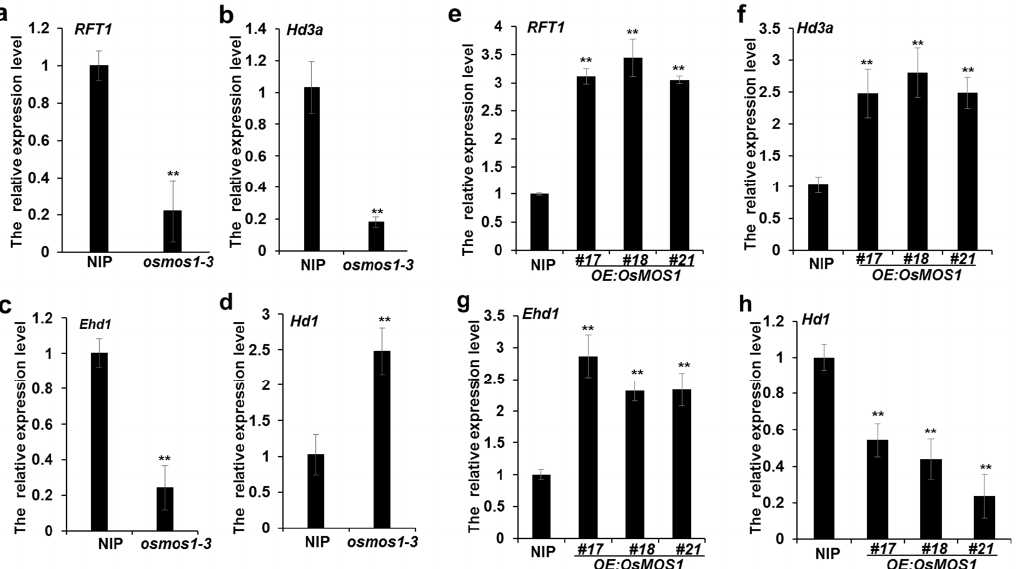
Figure 5. Expressions of the floral regulator genes in Nip, osmos1-3 , and OsMOS1 -overexpressing lines under LD conditions. ( a – d ) Expressions of the RFT1 ( a ), Hd3a ( b ), Ehd1 ( c ), and Hd1 ( d ) in Nip and osmos1-3 under LD conditions. ( e – h ) Expressions of RFT1 ( e ), Hd3a ( f ), Ehd1 ( g ), and Hd1 ( h ) in NIP and OsMOS1 -overexpressing lines under LD conditions. The fully emerged leaf blades from Nip, osmos1-3 , and OsMOS1- overexpressing plants under LD growth conditions were sampled at 45 days after germination. The expression of Hd1 was observed at ZT 14 h and other floral regulator genes were monitored at ZT 2 h. The rice ACTIN gene was used as the internal control. Error bars indicate the standard deviation, n = 3. Asterisks indicate a significant difference between NIP and osmos1-3 (** p < 0.01, Student’s t -test). 2.4. MOS1 Negatively Regulates Seed Size in Rice and Arabidopsis Grain phenotypic analysis indicated that OsMOS1 also affected grain size. The grain size of osmos1-3 was significantly larger than that of the wild-type NIP (Figure 6). The grain lengths, but not widths, of osmos1-3 increased by 8.3% compared with those of NIP (Figure 6a–c). As a result, the osmos1-3 mutant produced heavier grains (+8.2% in 1000-grain weight) than NIP (Figure 6d). However, there was no significant difference in the grain size between the wild-type NIP and OsMOS1 -overexpressing plants (Supplemental Fig- ure S4). To investigate whether the difference between osmos1-3 and NIP in grain size was caused by seed cell expansion, the outer glume epidermal cells were observed using a scanning electron microscope. As shown in Figure 6, the cell lengths and cell widths of osmos1-3 were greater than those of NIP (Figure 6e,f). Taken together, these results show that OsMOS1 negatively regulated grain size mainly by controlling the seed cell expan- sion.